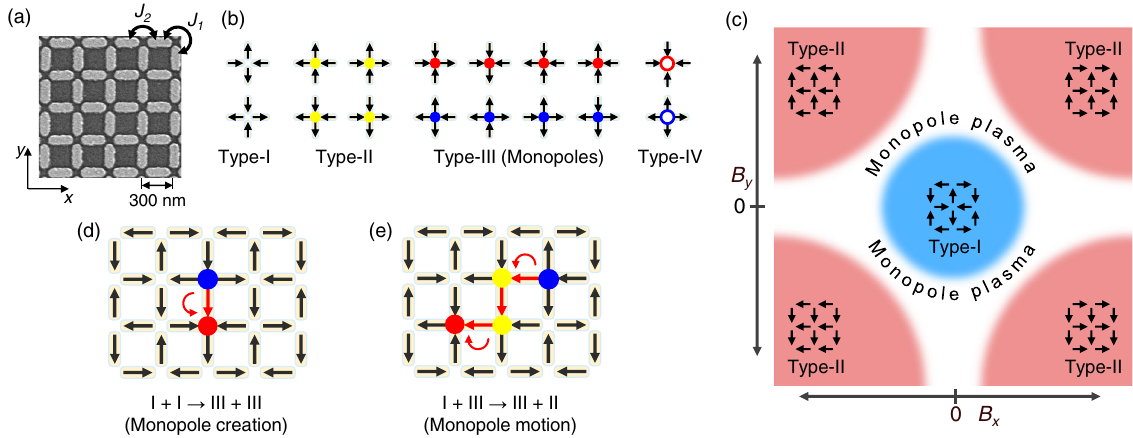
FIG. 1. Field-dependent phase diagram of thermally active square ASI. (a) Scanning electron microscopy image of the sample. Each Ni 0 Fe 0 island has lateral dimensions of 220 nm × 80 nm and thicknesses of 3.5 nm, and behaves as a single superparamagnetic Ising . 8 . 2 moment that, in the absence of any biasing field, exhibits rapid thermodynamic fluctuations near room temperature. (b) Four vertex types in archetypal square ASI, in order of increasing energy at zero applied magnetic field. Type-I vertices have the lowest energy because the nearest-neighbor dipolar coupling J 1 exceeds the next-nearest-neighbor coupling J 2 . Types-I and -II vertices have 2-in-2-out configurations and therefore obey ice rules (but only type-II vertices have a net polarization), while type-III vertices have 3-in-1-out or 3- out-1-in configurations and therefore have a monopole effective magnetic “ charge. ” (Type-IV vertices also have magnetic charge but are energetically very unfavorable and only rarely occur.) (c) Notional schematic of the anticipated field-dependent phase diagram of square ASI, showing the two well-defined ground states of the system: full tiling with type-I vertices at small applied fields B x;y ≈ 0 , and polarized type-II vertex tiling when j B x j and j B y j are both large. Near the boundaries, the equilibrium dynamics are determined by the thermal creation, annihilation, and motion of type-III monopole vertices, which generate magnetization noise. (d) Schematic showing how a thermal fluctuation in the type-I phase creates a pair of type-III monopole vertices. (e) Subsequent fluctuations can cause the monopoles to diffuse, leaving behind a Dirac string of type-II (yellow) vertices. Red arrows show islands that have flipped; blue and red dots indicate the mobile monopole